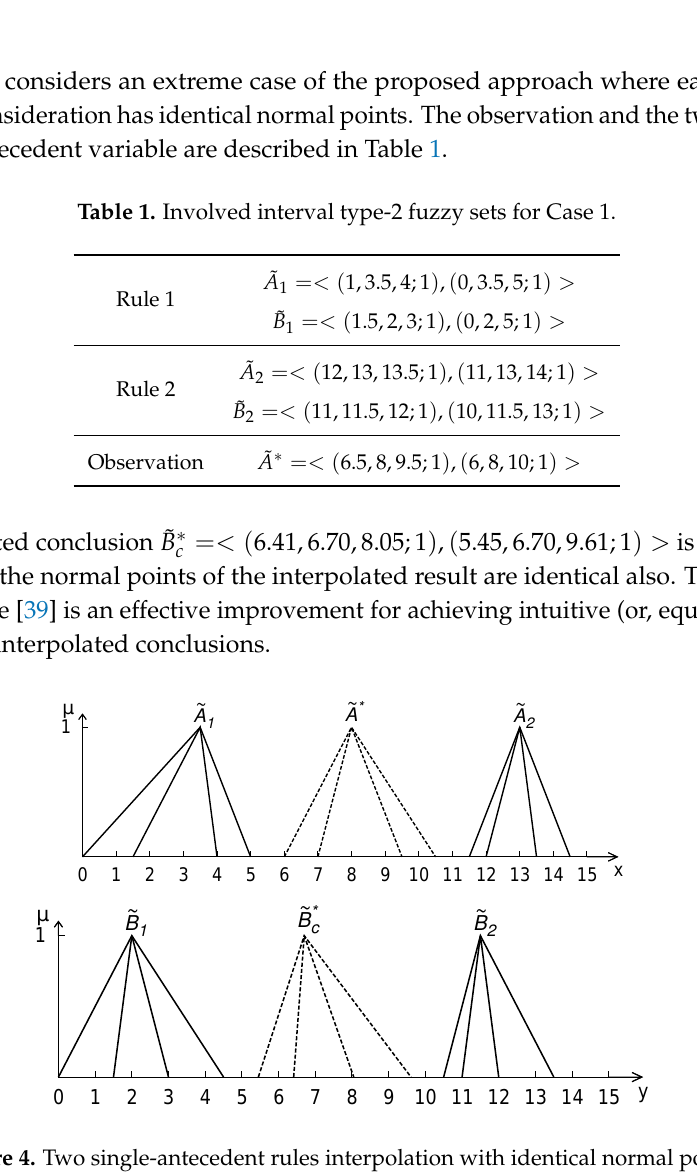
Figure 4. Two single-antecedent rules interpolation with identical normal